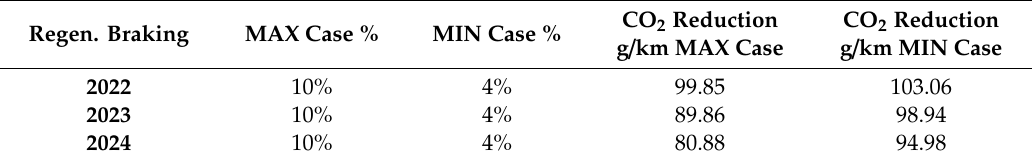
Table 5. CO 2 Reduction in Regenerative Braking Technology.